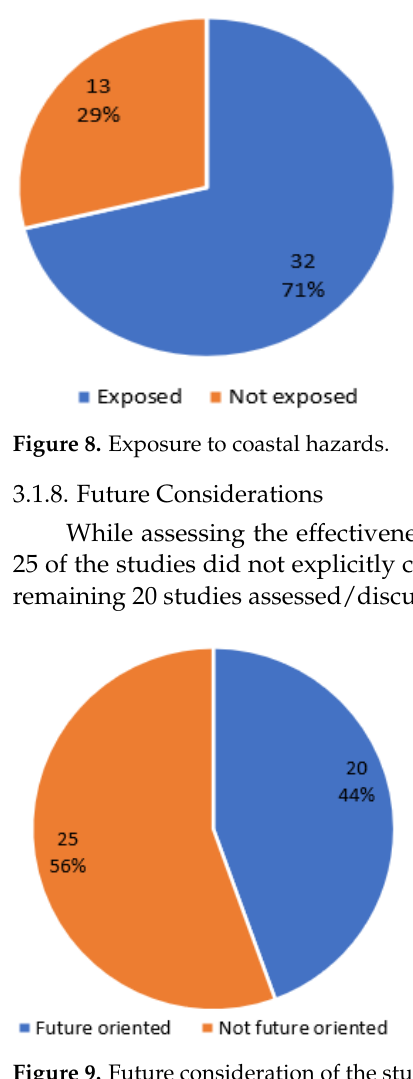
Table 2. Scientific evidence (benefits) from selected studies.